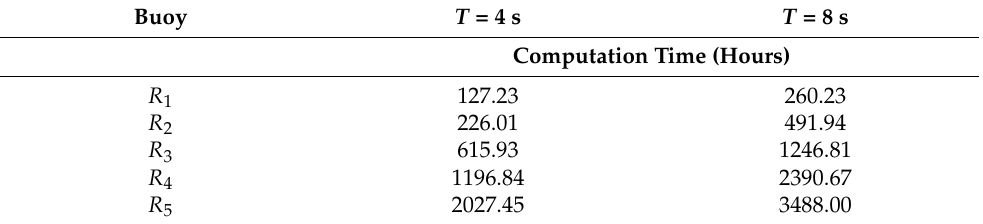
Table 3. Computation time using the mesh morphing method.